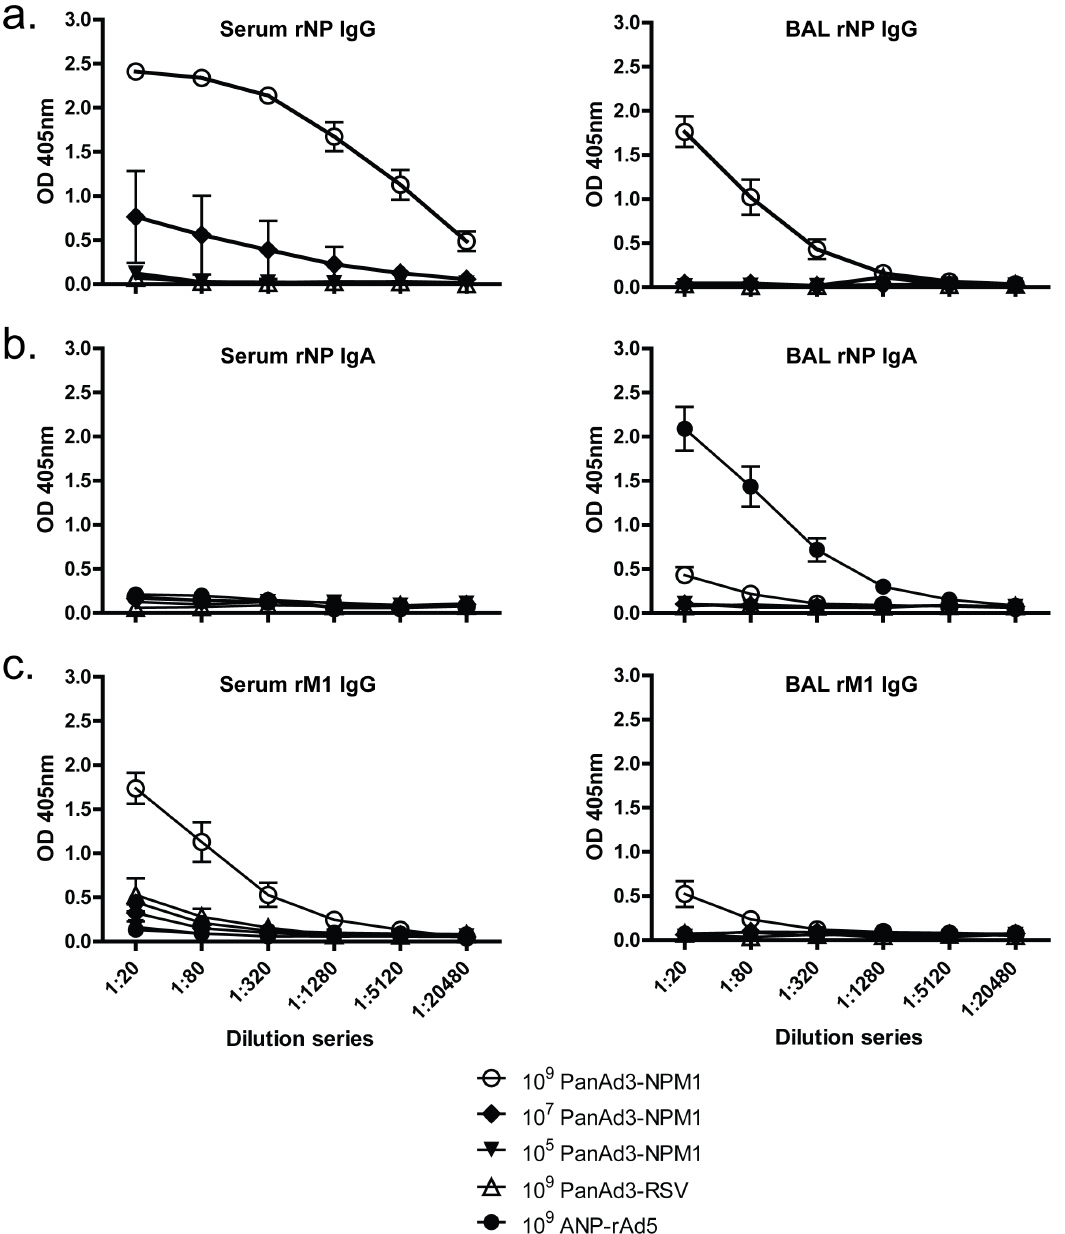
Figure 4. Antibody responses to different doses of PanAd3NPM1. Mice were vaccinated with indicated doses. Four weeks later mice were sacrificed, and serum and BAL were collected for antibody analysis. Error bars indicate mean 6 SEM. a) ELISA for IgG antibodies to rNP in the serum and BAL. b) ELISA for IgA antibodies to rNP in the serum and BAL. c) ELISA for IgG antibodies to rM1 in the serum and BAL.